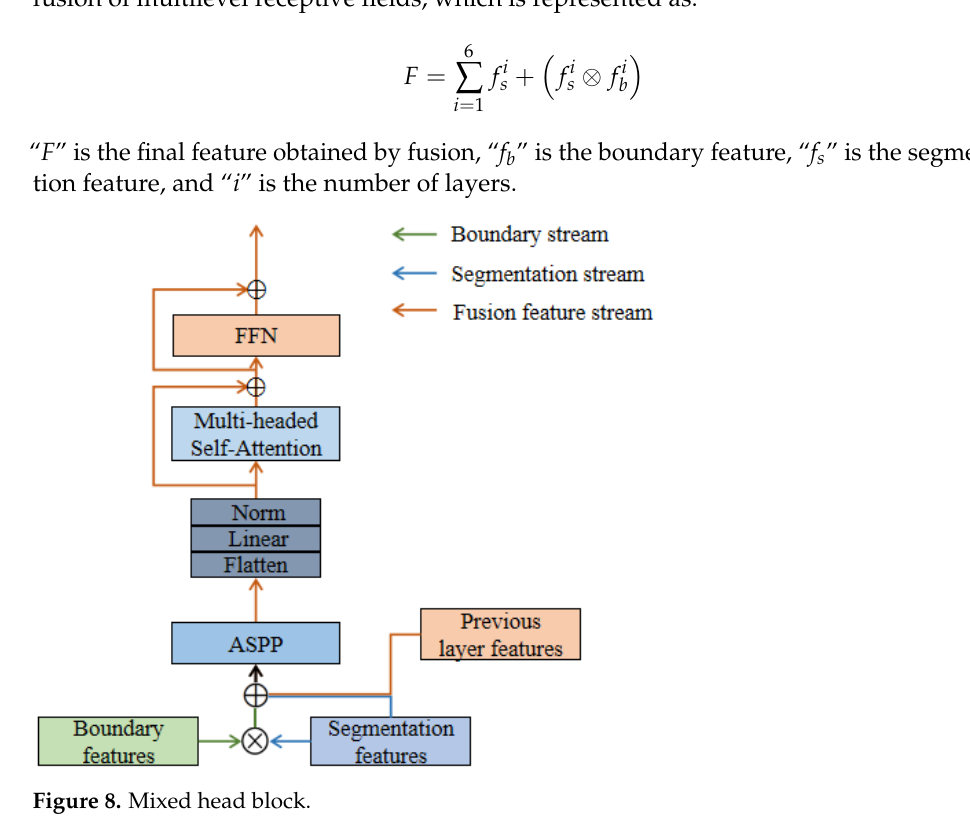
10 of 22 Figure 7. Transformer conversion head.